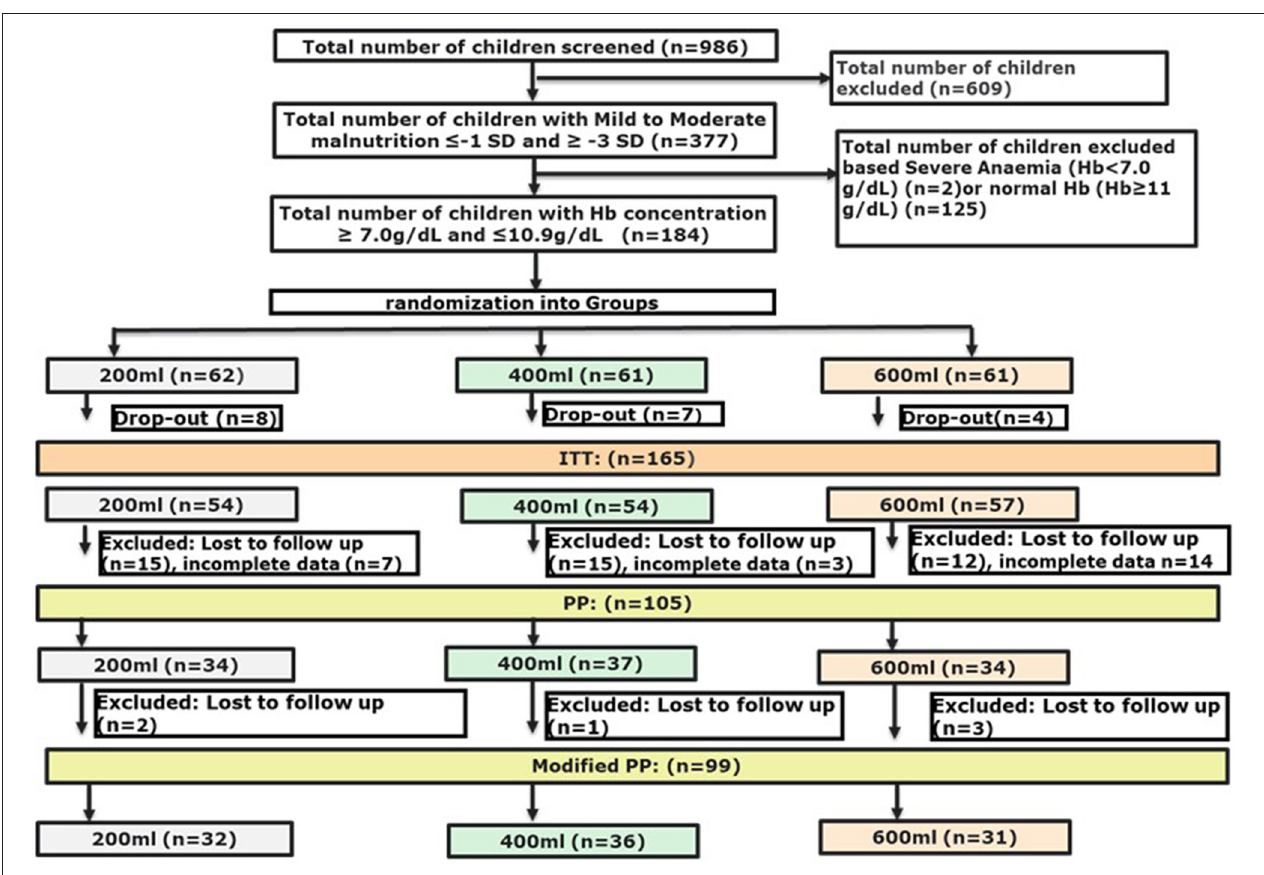
FIGURE 1 | Flow-chart of screening and randomisation